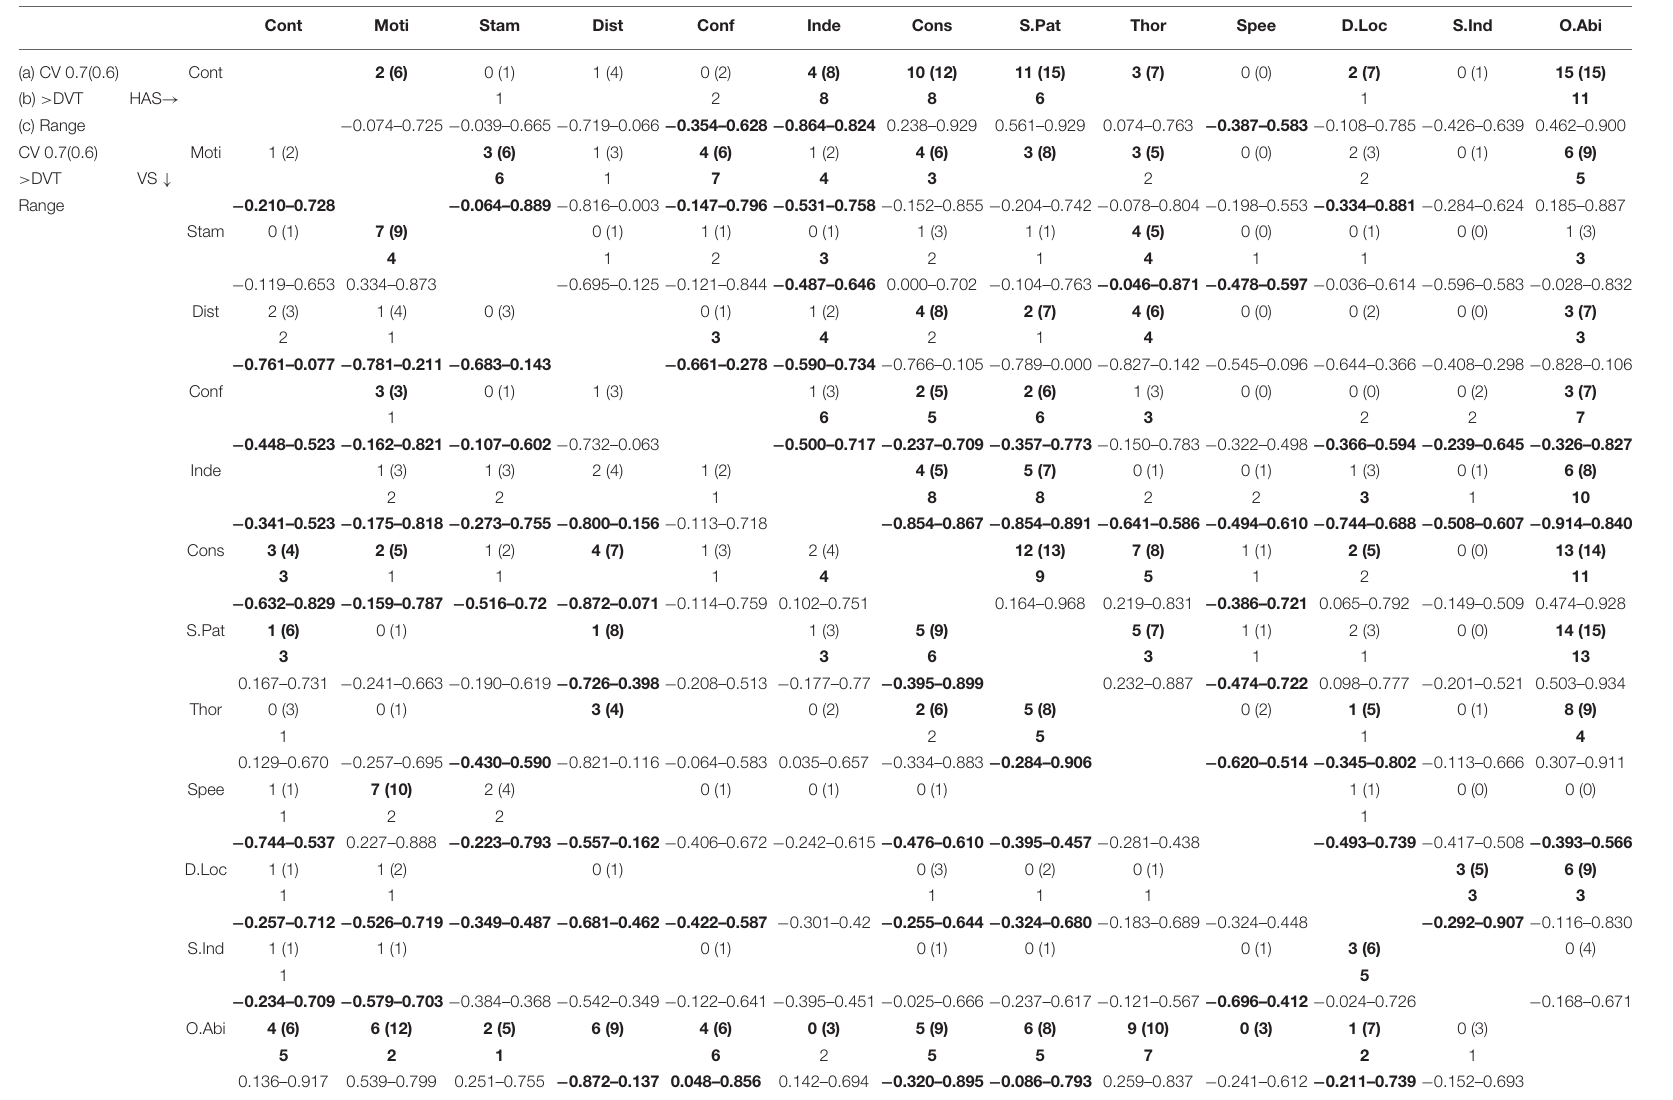
TABLE 3b | Incidence of raters exceeding thresholds for convergent and discriminant validity and range of within-rater coefficients (VS lower left section of table and HAS upper right section). Cont Moti Stam